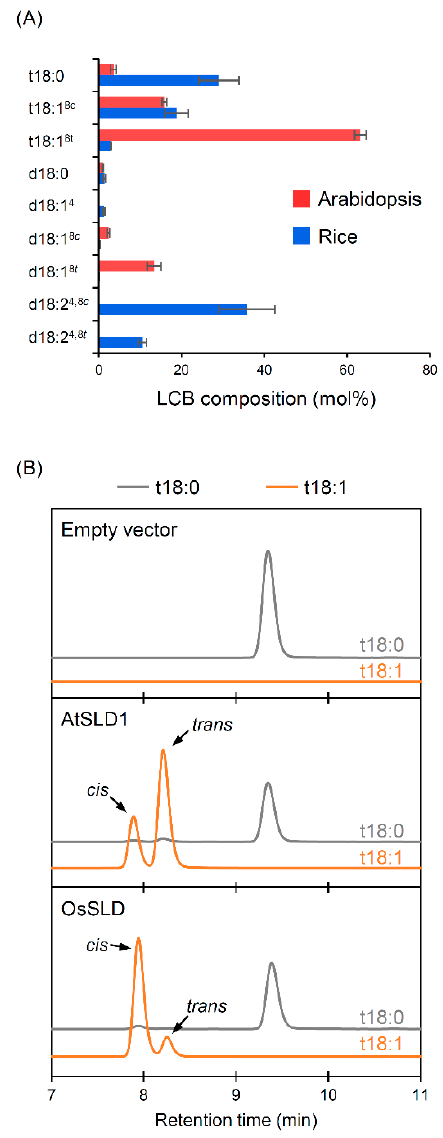
Figure 1. Different isomerism of long-chain base (LCB) Δ 8 unsaturation in rice and Arabidopsis. ( A ) Total LCB profiles in vegetative leaves of Arabidopsis and rice. Data are means ± SD ( n = 4). ( B ) LC- MS/MS chromatograms of t18 LCBs in yeast expressing AtSLD1 or OsSLD. 4-nitro-7-benzofurazan (NBD-F) derivatives of t18:0 and t18:1 were monitored by m / z 479.4 > 193.1 and 477.4 > 193.1, respectively.